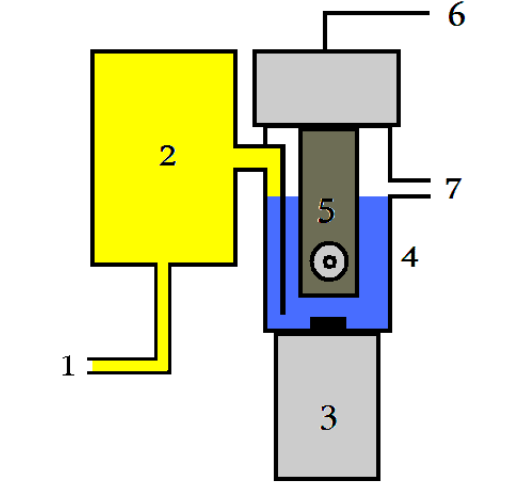
Figure 3. Prospective concept of device for detection of organophosate pesticides and nerve agents. The main parts are followings: input of sample (1); pumping of sample eventually mixing with a fresh substrate (2); magnetic stirring (3); reaction cell (4); biosensor based on screen printed electrodes and immobilized AChE (5); signal output (6); outlet of superfluous substrate